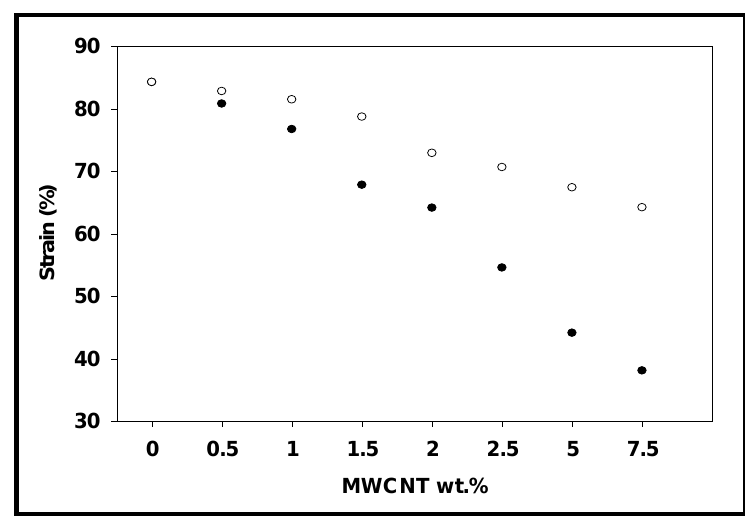
Figure 11. Tensile modulus variation with CNT loading in Ar-CNT-P ( ○ ) and Ar-CNT-C (●) composites.